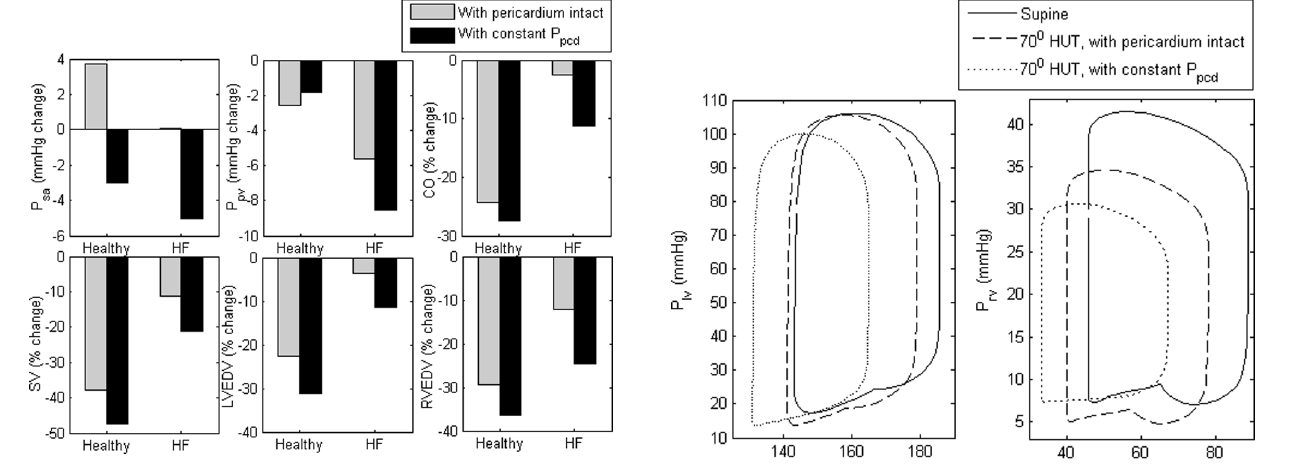
Figure 6. Effect of pericardial constraint on mean arterial pressure ( P sa ), pulmonary venous pressure ( P pv ), mean cardiac output ( CO ), stroke volume ( SV ), LV end diastolic volume ( LVEDV ) and RV end diastolic volume ( RVEDV ). Absolute value changes in the mean arterial pressure ( P sa ) and mean pulmonary venous pressure ( P pv ), as well as percentage changes in the mean cardiac output ( CO ), stroke volume ( SV ), LV end diastolic volume ( LVEDV ) and RV end diastolic volume ( RVEDV ) from the supine position to 70 o HUT for both healthy and heart failure (HF) conditions, with (i) pericardium intact and (ii) constant pericardial pressure ( P pcd ).